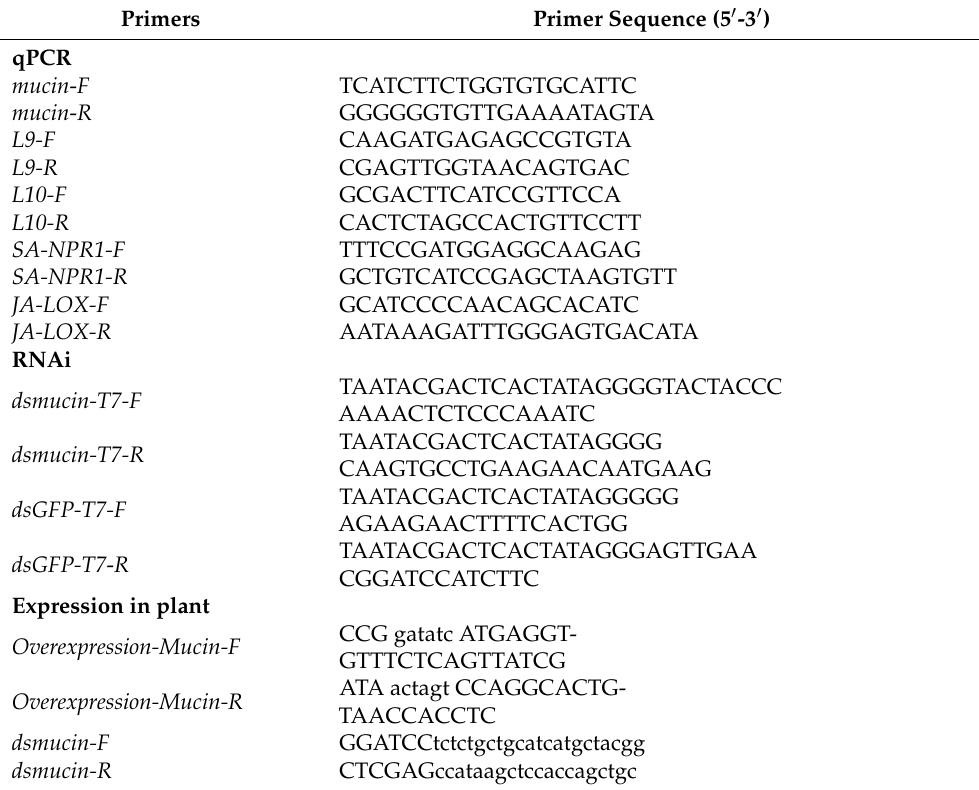
Table 1. The primers used in this study. Primers Primer Sequence (5 (cid:48) -3 (cid:48)